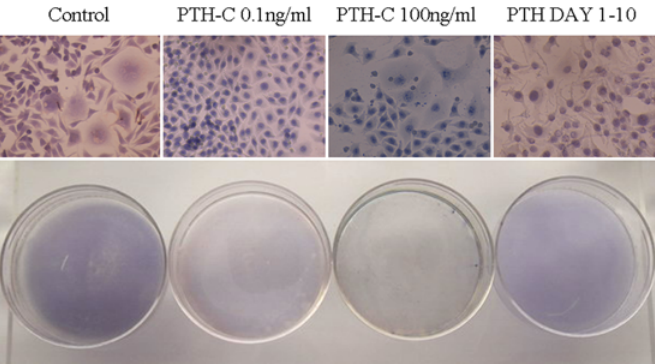
Fig 3. AKP histochemical staining. AKP activity of osteoblasts was evaluated by histochemical staining. AKP granules that are abundantly expressed in the cytoplasm of mature osteoblasts were stained red-brown with purple nuclei. The control group had the highest AKP activity of all groups. AKP granules in the PTH Day 1 – 10 group exhibited light red staining, while reddish staining was observed in the PTH-C 0.1 ng/mL group, and red-brown staining was observed in controls. AKP activity was weakest in the PTH-C 100 ng/mL group and few AKP granules were formed.